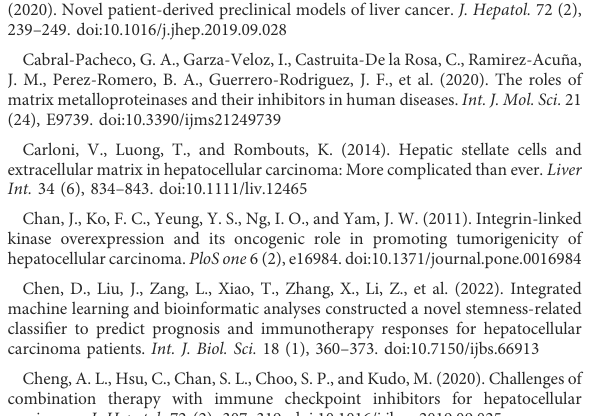
SUPPLEMENTARY FIGURE S1 Schematic illustration of study ’ s design. This study is mainly divided into three parts: fi rst, identifying ECM-related genes; second, constructing a prognosticsignaturebasedonECM-relatedgenes;and fi nallyanalyzing the multi-omics features underlying the signature. ECM, extracellular matrix. SUPPLEMENTARY FIGURE S2 (A) Correlation analysis of 75 ECM-related genes with stemness. (B) Correlation analysis of 10 selected ECM-related genes and MMP family. (C) Correlation analysis of 10 selected ECM-related genes and collagen or non-collagen. ECM, extracellular matrix; MMP, matrix metalloproteinase. SUPPLEMENTARY FIGURE S3 Performance comparison of ECM-related prognostic prediction signature and stemness-related prognostic prediction signatures. (A) LASSOregressionanalysisshowed thepartial likelihooddeviationcurve of the minimum number genes corresponding to the covariates. (B) Kaplan – Meier curves showing different overall survival of patients in high- and low-risk groups. (C) ROC curves of stemness-related signature for predicting the 1/3/5-year overall survival. ECM, extracellular matrix; LASSO, least absolute shrinkage and selection operator; ROC, receiver operating characteristic. SUPPLEMENTARY FIGURE S4 Correlation analysis of the tumor doubling time and the risk